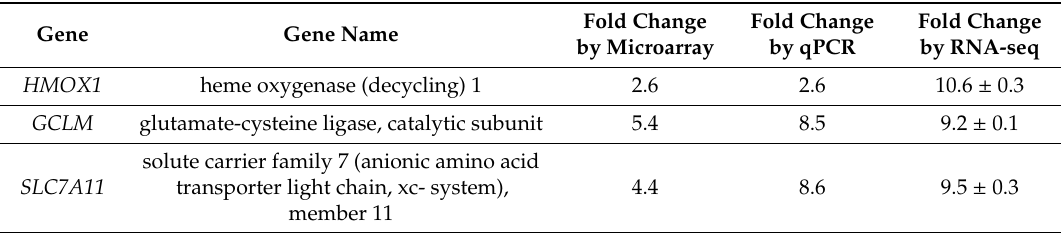
Table 2. Upregulation of selected canonical Nrf2 regulated genes and verification of gene expression upregulation of those genes by microarray, quantitative PCR (qPCR) and RNA-seq assays in HepG2 cells treated with PB125 (qPCR data normalized to GAPDH, average from two samples for each group)(RNA-seq data mean ± SEM, n = 3 for PB125 and untreated groups, p < 0.01 for each gene). Treatment of cultured HepG2 cells with PB125 (16 µ g / mL) increased gene expression of HMOX1 , GCLM , and SLC7A11